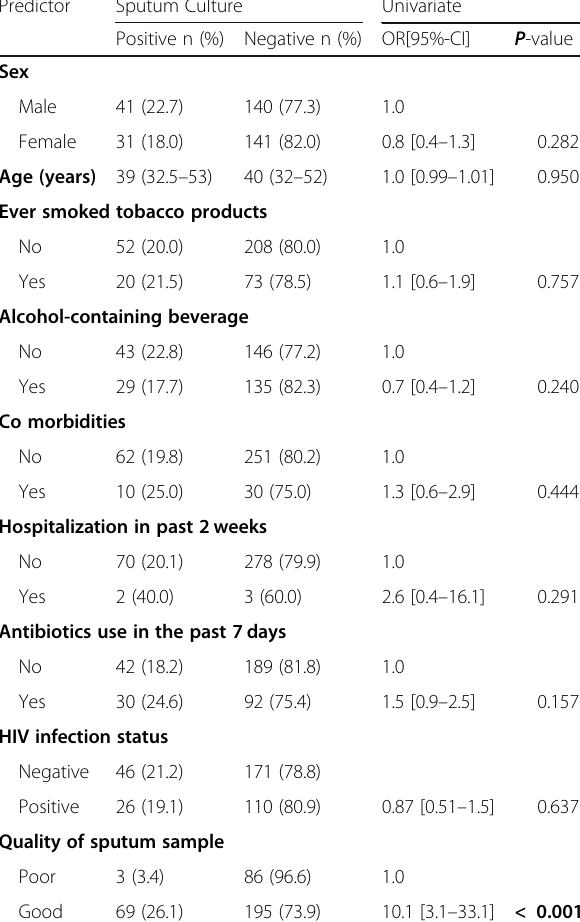
Table 4 Factors associated with Sputum Culture Positive of 353 adult patients with pneumonia between August and December 2015 in Mwanza, Tanzania Predictor Sputum Culture